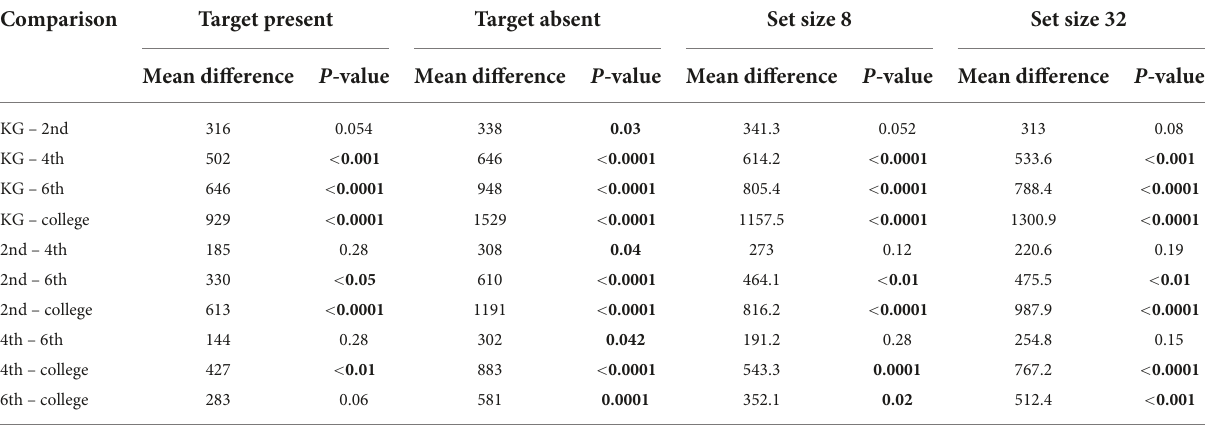
TABLE 5 Post hoc comparisons for RT (in ms) in the visual search task between different grade levels under different target and set size conditions.